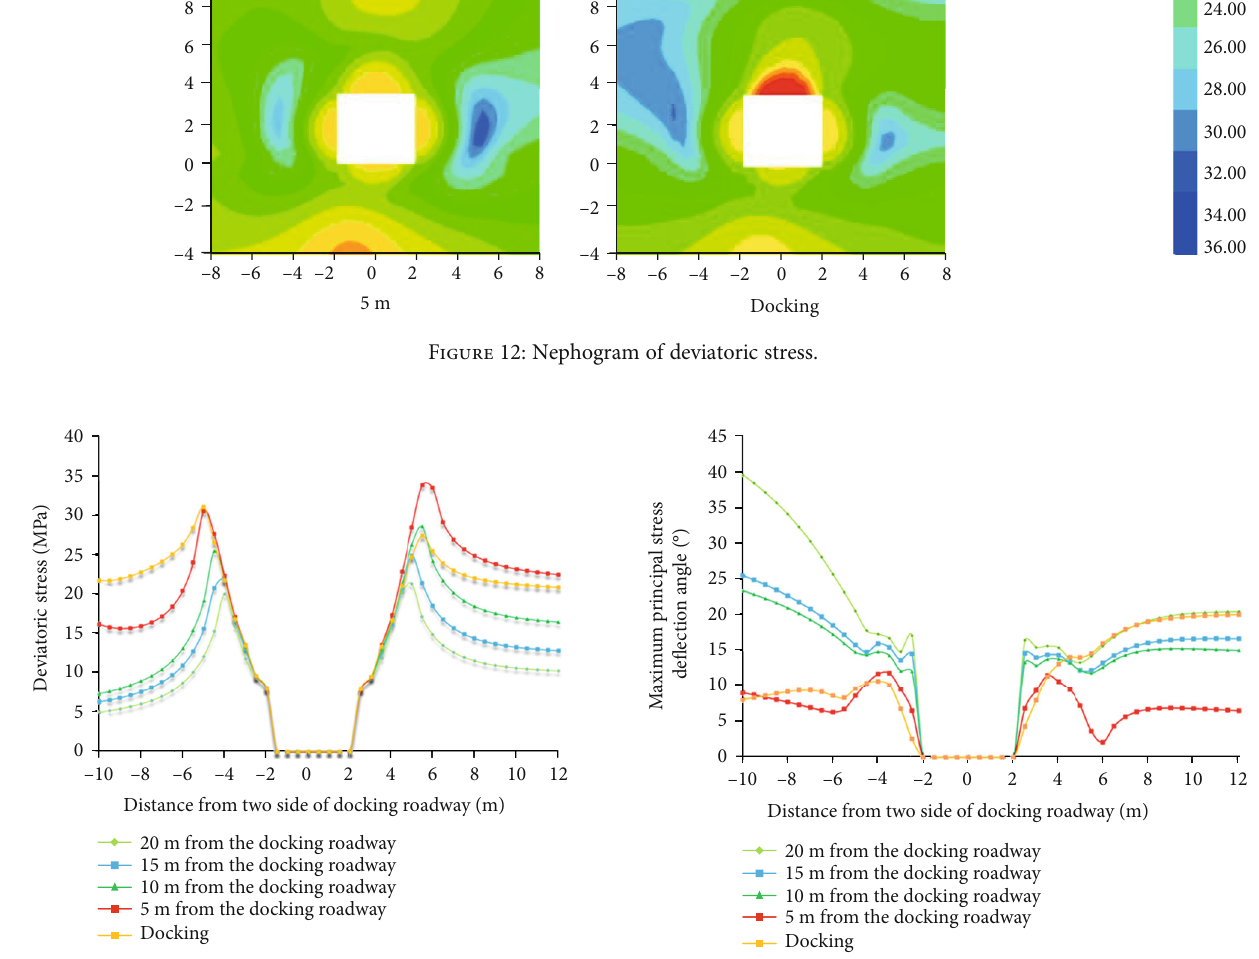
Figure 13: Deviatoric stress curve of two sides. Figure